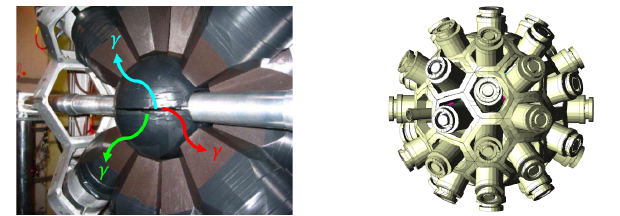
Figure 1. One hemisphere of the TAC consisting of the BaF 2 detectors, the neutron beam tube and the neutron absorber. A cascade event of three γ rays is depicted. If all γ rays are detected the crystal multiplicity is m cr = 3 (left). The geometry of the full TAC as implemented in GEANT4